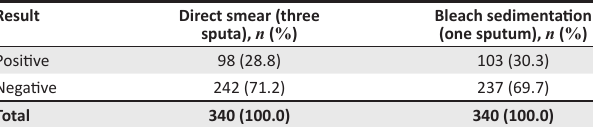
FIGURE 1: Positive (a) and negative (b) Lowenstein-Jensen cultures for M. tuberculosis . TABLE 2: Results of Ziehl-Neelsen microscopy for acid-fast bacilli using both direct and bleach sedimentation-treated sputa, Abuja, Nigeria, November 2004 to July 2005.